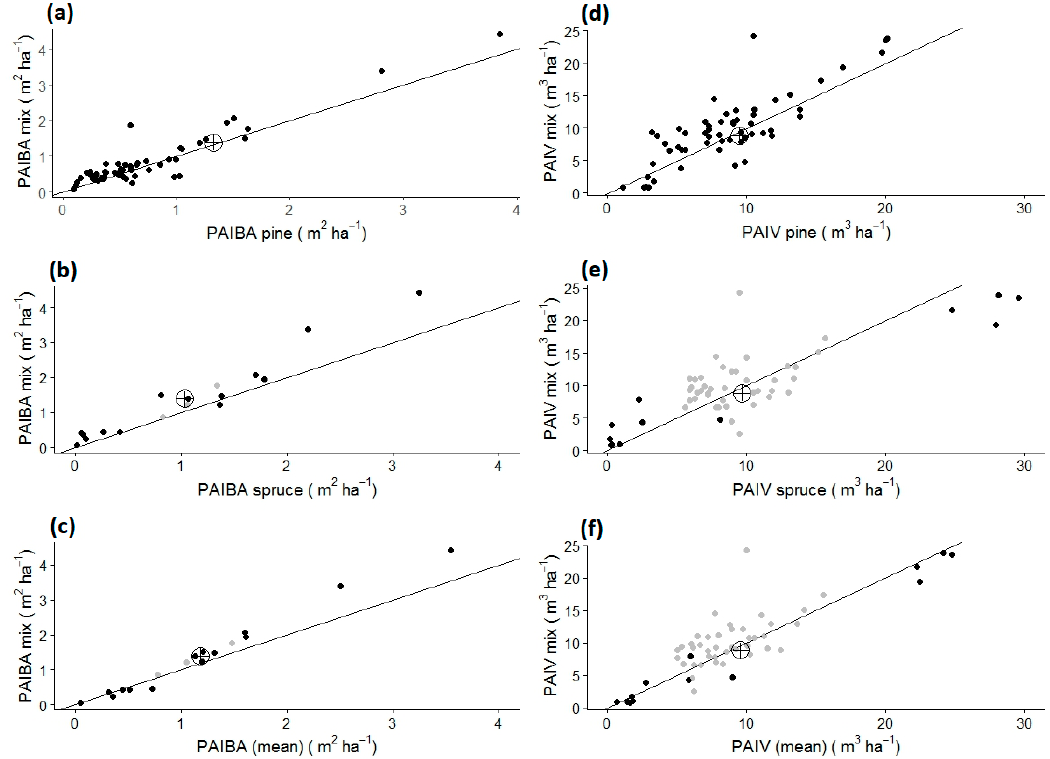
Figure 3. Periodic annual increment of basal area and standing volume (PAIBA and PAIV) in mixed tree species and pure stands of the experiments during different measurement periods: ( a , d ) mixed stand and pine, ( b , e ) mixed stand and spruce, and ( c , f ) mixed stand and the mean of both monocultures. The larger circle with the cross illustrates the mean of all observed increment values. Grey color indicates values where growth of pure spruce was estimated.